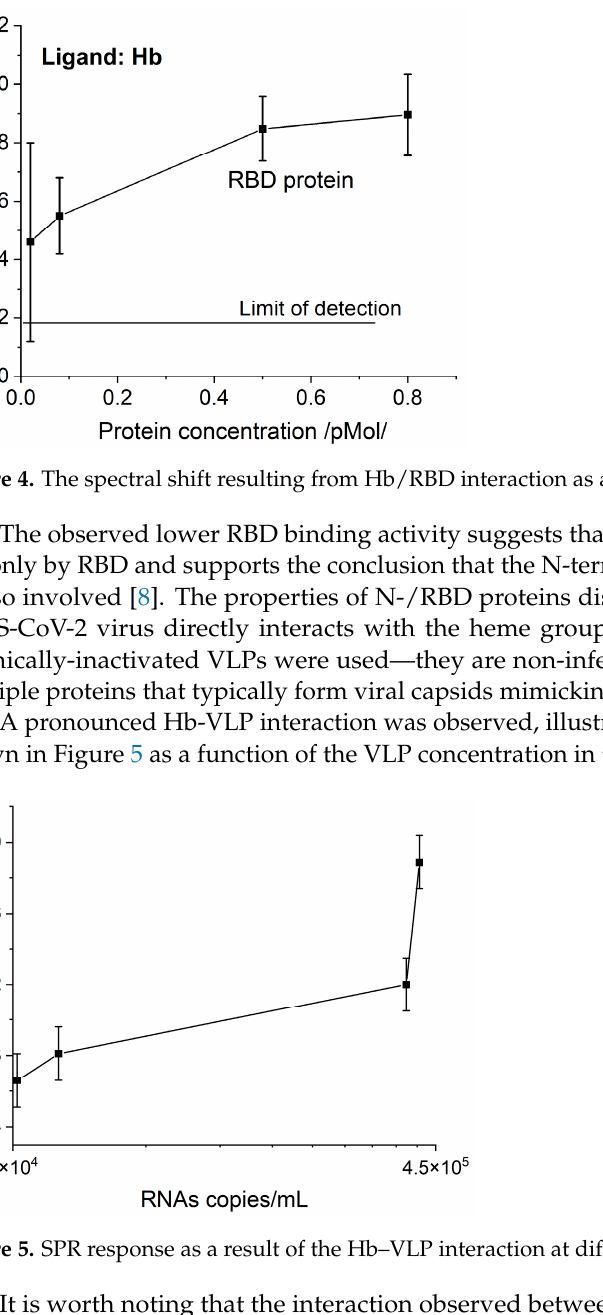
Figure 5. SPR response as a result of the Hb–VLP interaction at di ff erent concentrations .